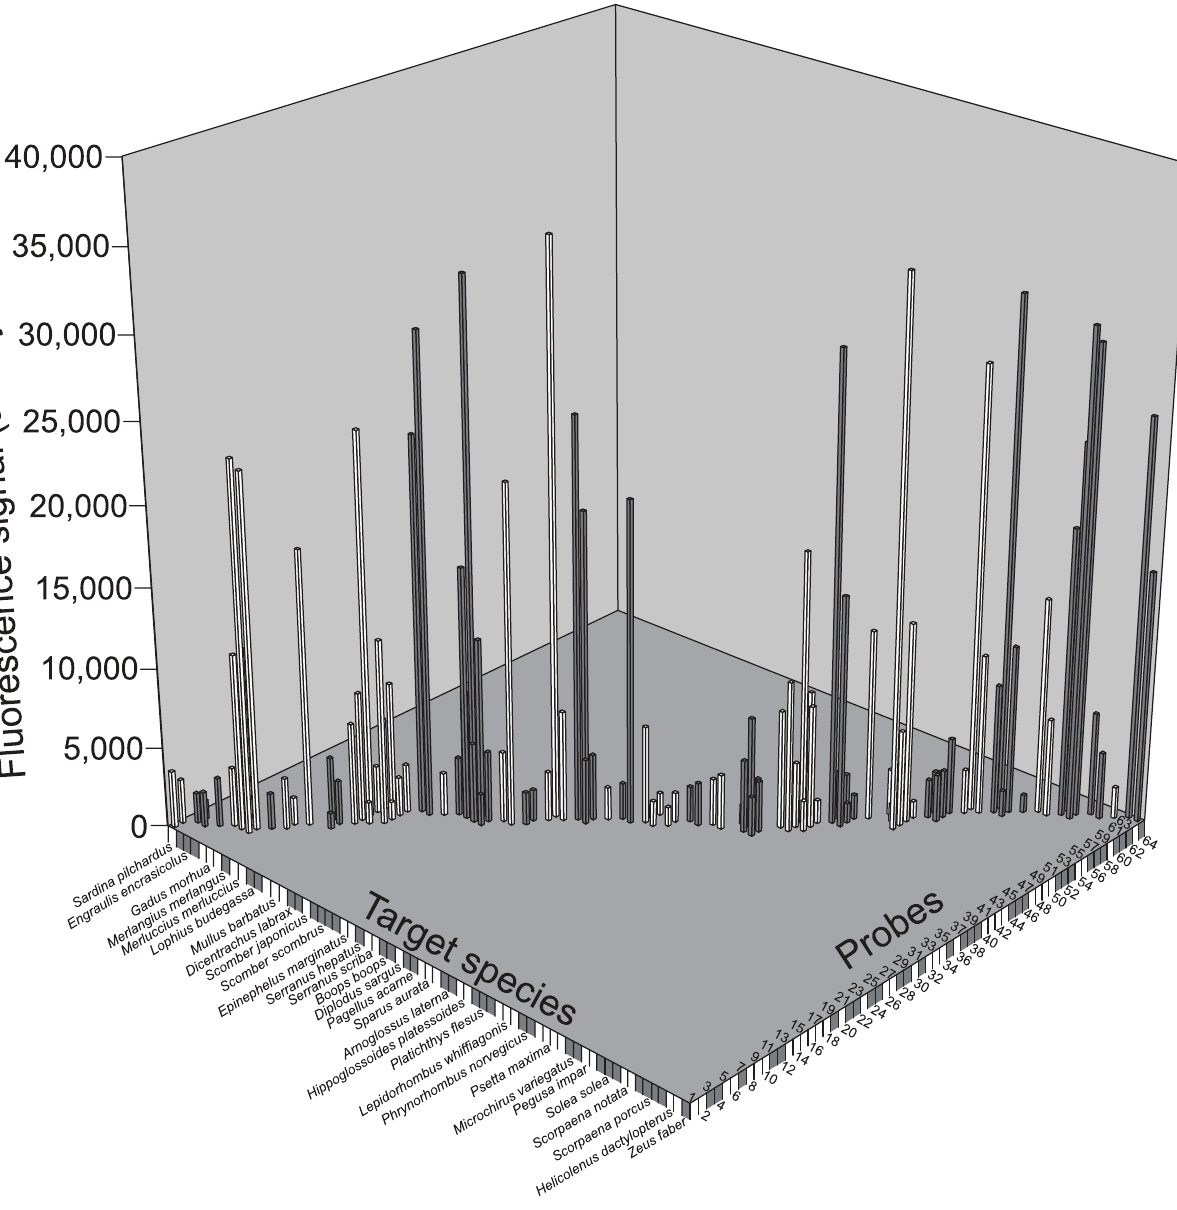
Figure 6. DNA microarray hybridisation experiments. Mean signal intensities of single target hybridisations to 64 oligonucleotide probes on a DNA microarray for the identification of 30 fish species from European seas. For numbers given to oligonucleotide probes refer to Table 3 and Supporting Information Table S2.